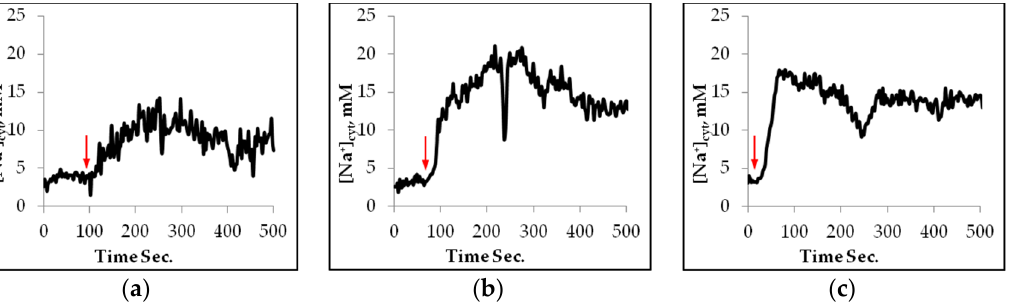
Figure 1. Changes of [Na + cyt ] in mM with time upon addition of 100 mM of NaCl to single mesophyll protoplasts of Arabidopsis wild type ( a ), sos1 ‐ 1 ( b ), and nhx1 ( c ). Measurements at excitation ratio 340/380 nm and emission 510–550 nm. Typical traces.